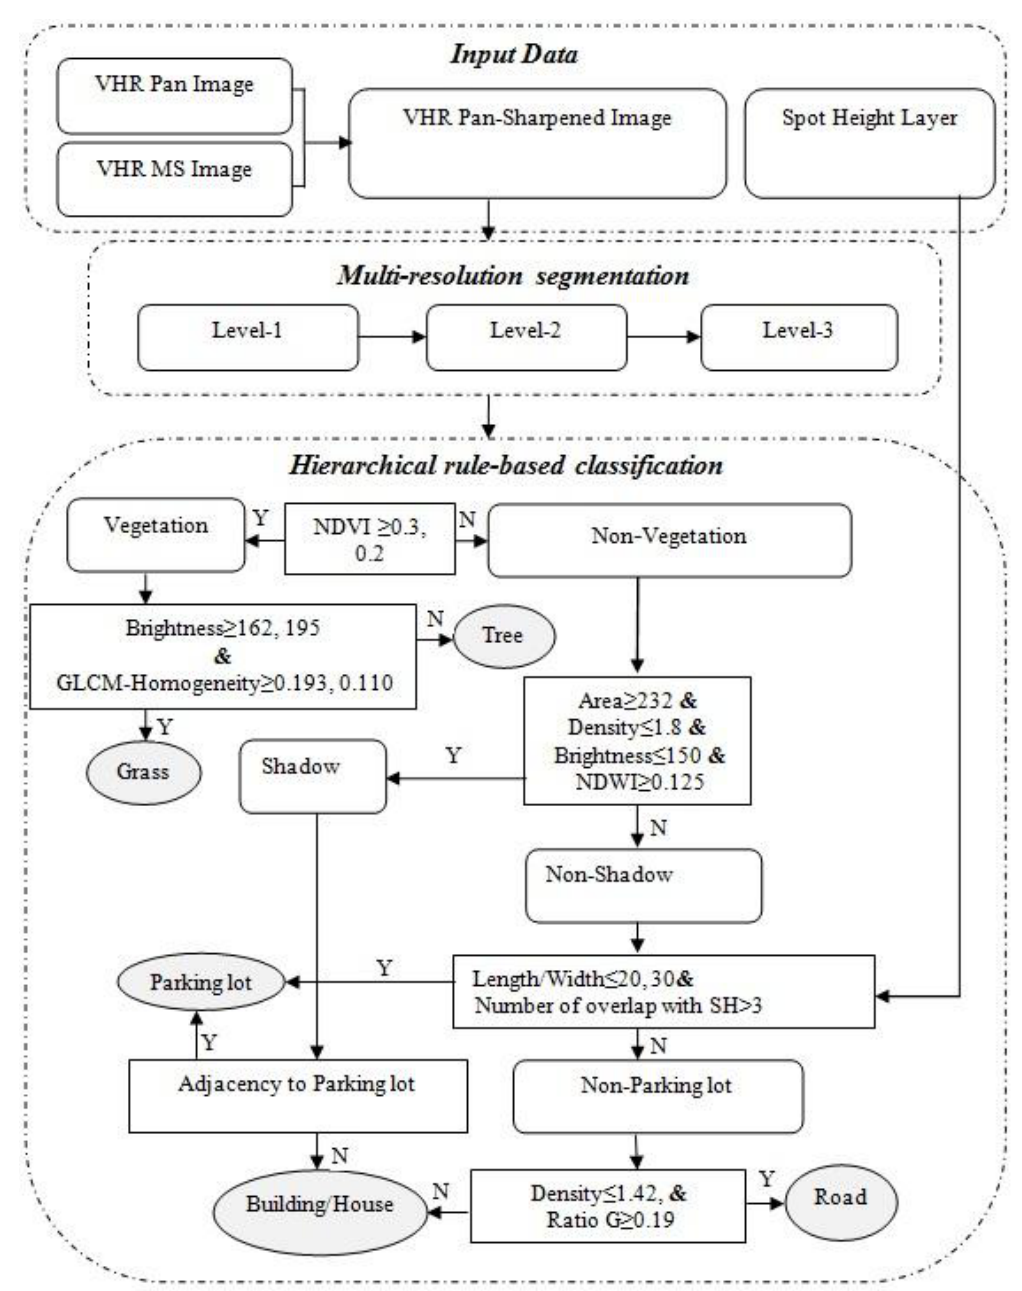
Figure 3. Flowchart of the developed rule-based expert system. Final classification results are shown in oval shape. The first and second thresholds for some features represent the threshold for QB and IK, respectively. When the threshold is identical for both images only one value is